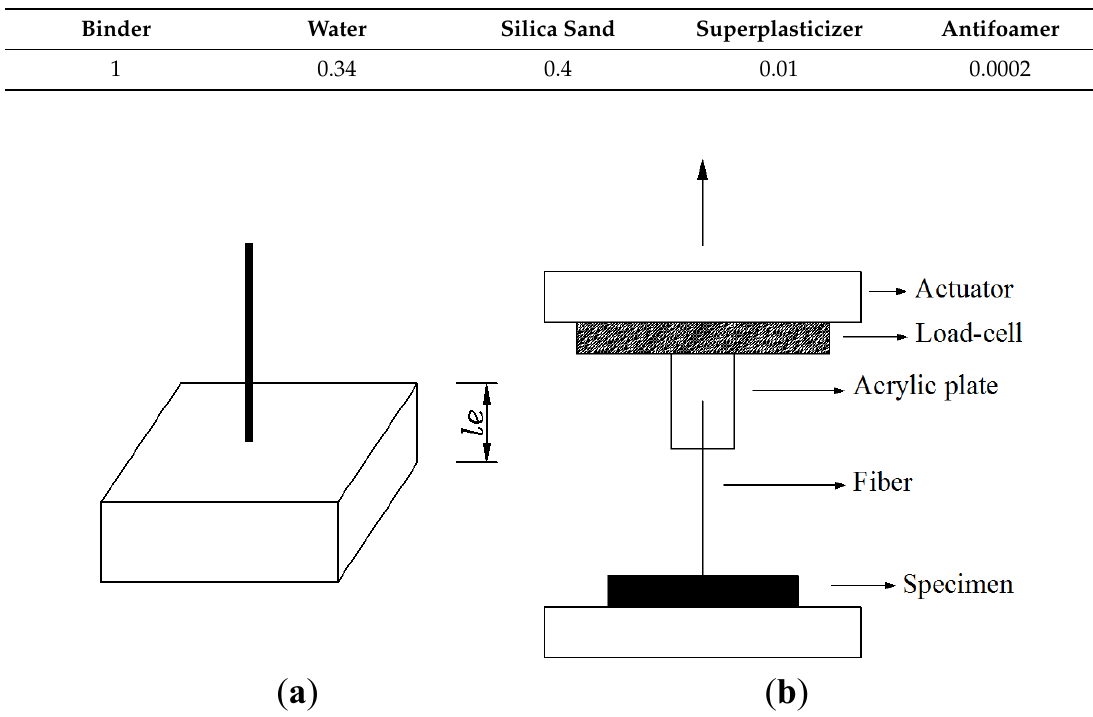
Figure 1. Specimen and test setup for fiber pullout test: ( a ) specimen and ( b ) test setup.